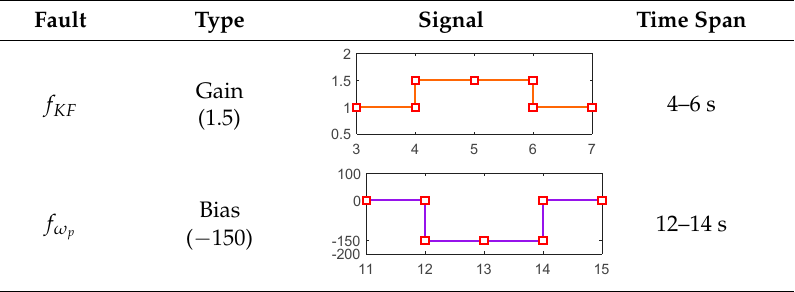
Table 5. Injected faults setting in the HTC.